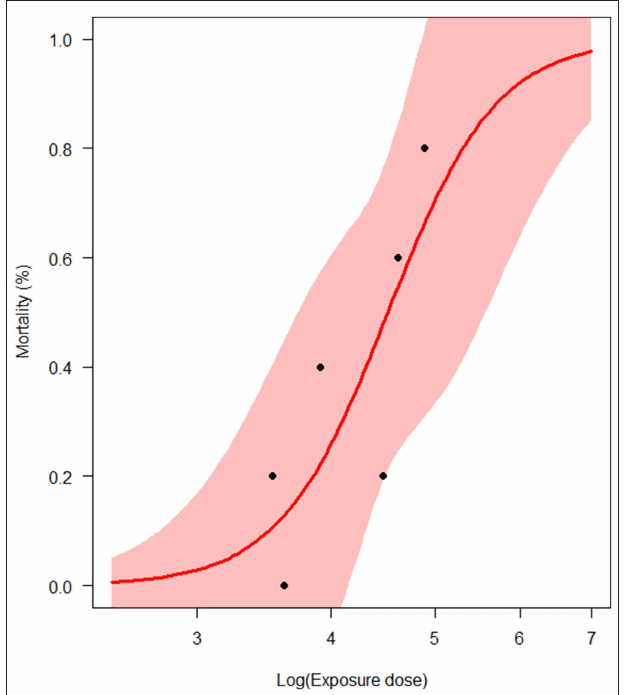
FIGURE 3 | Estimation of the half-lethal dose (LD 50 ) of Vibrio aestuarianus infection ( N = 6 experimental trials). The pink area represents the 95% confidence interval of the